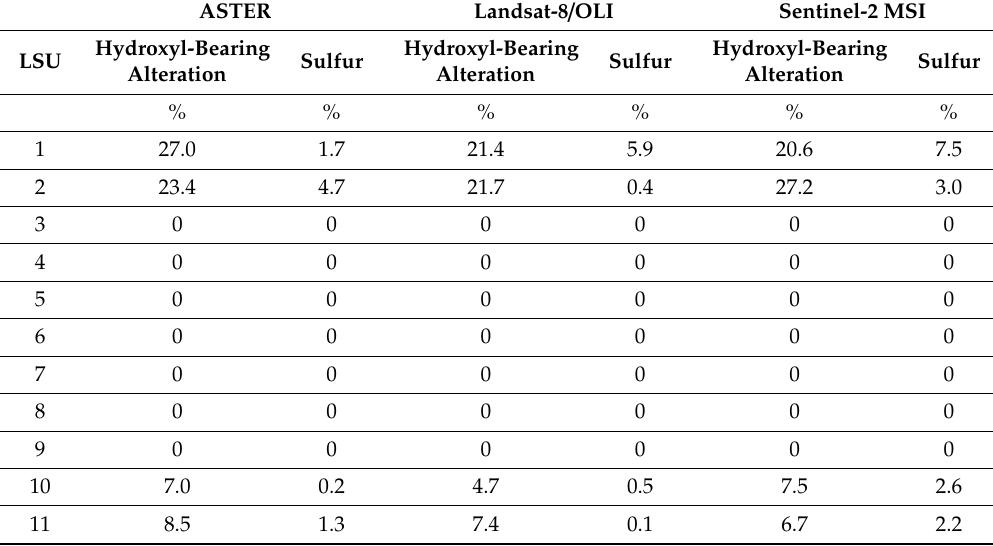
Table 5. Percentage of surface a ff ected by high hydroxyl-bearing alteration within each LSU (described in Section